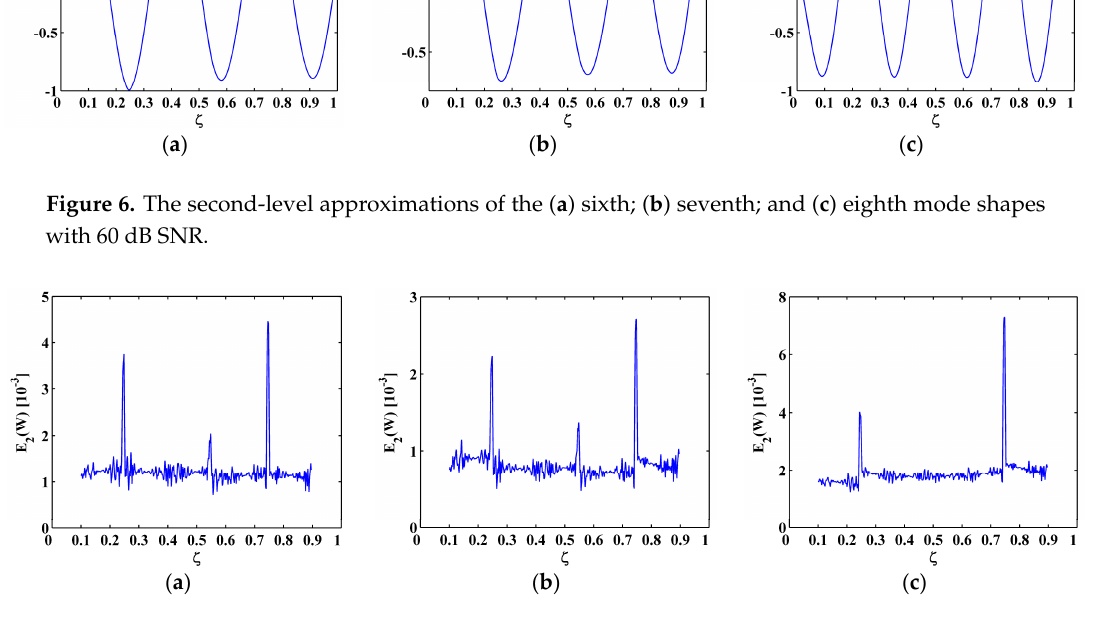
( c ) Figure 8. MRM-TKE for the ( a ) sixth; ( b ) seventh; and ( c ) eighth mode shapes with 55 dB SNR. ( a ) ( b ) ( c ) Figure 9. MRM-TKE for the ( a ) sixth; ( b ) seventh; and ( c ) eighth mode shapes with 50 dB SNR.